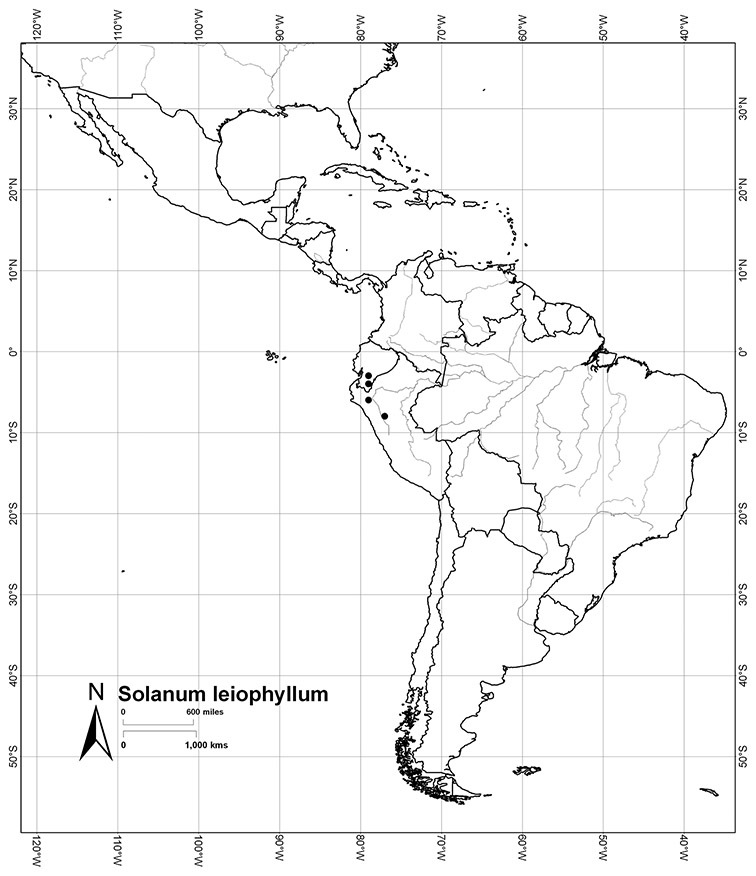
Distribution of Solanum leiophyllum Benth.